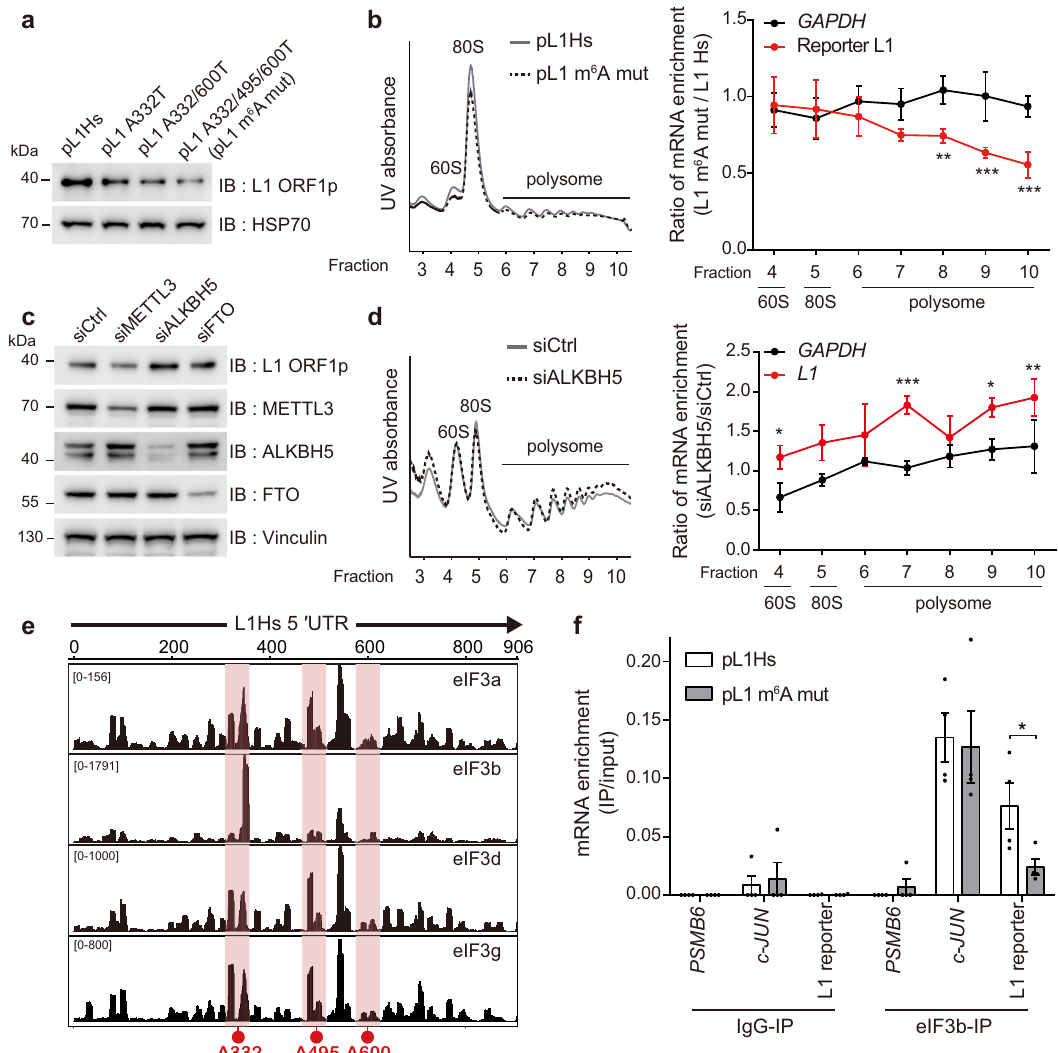
Fig. 4 L1 5 ′ UTR m 6 A cluster enhances the translational ef fi ciency through the recruitment of eIF3. a Immunoblot analysis for assessing the effect of m6A mutation in L1 ORF1p levels. HSP70 served as a loading control. The immunoblot images are representative of three independent experiments. b Polysome pro fi ling of pL1Hs- or pL1 m 6 A mut-expressing HeLa cells (left panel). Ratio of the polysome-bound mRNA levels in pL1 m 6 A mut-expressing cells to those in pL1Hs-expressing cells (right panel). The levels of RNA in each polysome fraction were normalized to the spike-in control and to the levels of input RNA. ( n = 4 independent samples, mean ± s.d., two-way ANOVA and Bonferroni ’ s multiple comparisons test; *** p < 0.001, ** p < 0.01, and * p < 0.05 in comparison to the enrichment ratio of GAPDH in each fraction). c Immunoblot assay for determining endogenous L1 ORF1p levels in PA-1 cells treated with indicated siRNAs. Vinculin served as a loading control. Quanti fi cation of L1 ORF1p levels is shown as values normalized to those of Vinculin in Supplementary Fig. 7C. The immunoblot images are representative of four independent experiments. d Polysome pro fi ling of PA-1 cells lacking ALKBH5 compared to siCtrl (left panels). The levels of endogenous L1 RNA was measured as in b using L1 5 ′ UTR-speci fi c primers (right panel). ( n = 3 independent samples, mean ± s.d., statistical signi fi cance was determined as in b ). e Identi fi cation of eIF3-binding sites in L1Hs 5 ′ UTR using the previously reported eIF3 PAR-CLIP data set (GSE65004) 38 . The red boxes indicate the m 6 A sites-containing region. f eIF3 UV-CLIP-qPCR using pL1Hs- or pL1 m 6 A mut-expressing HeLa cells. IgG-IP and PSMB6 served as negative controls ( n = 4 independent samples, mean ± s.e.m., unpaired two-tailed t -test; * p < 0.05). Source data are provided as a Source data fi